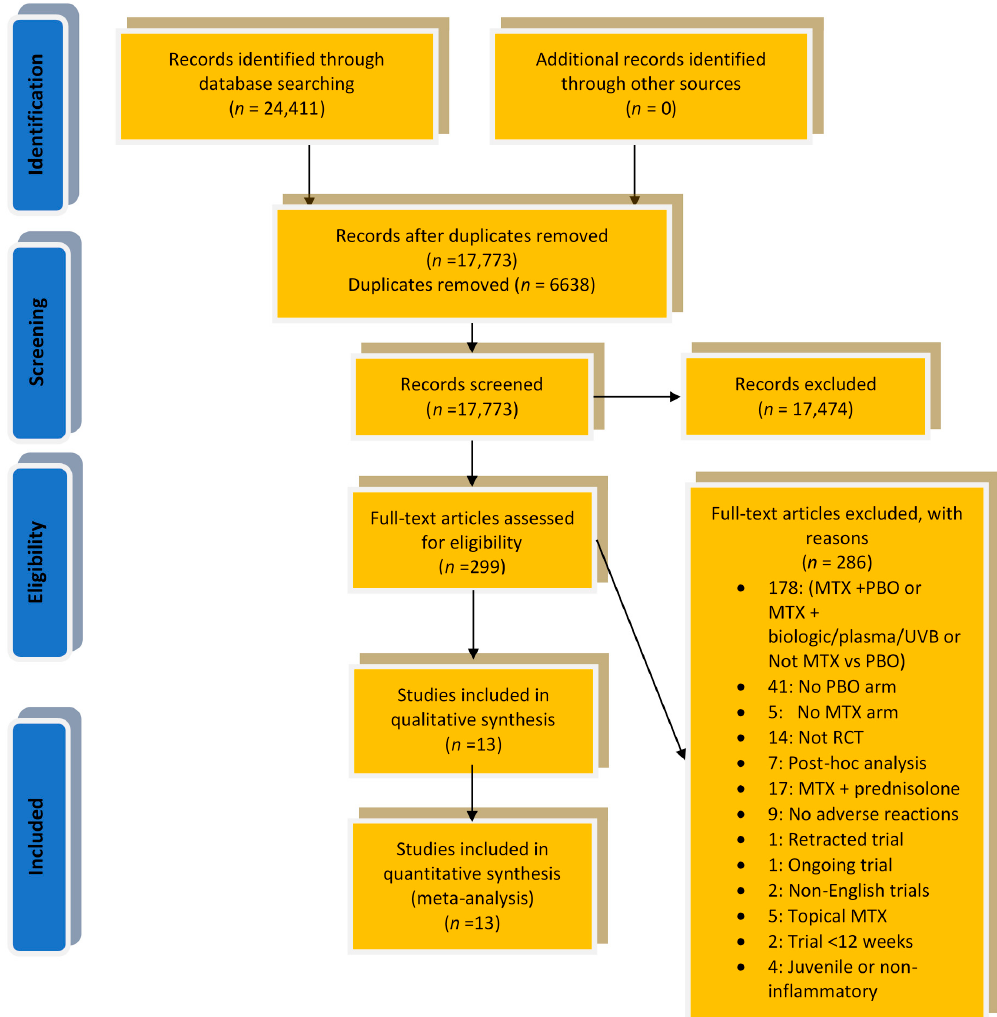
Figure 1. PRISMA flow diagram: Risk of infection of methotrexate therapy in inflammatory diseases (abbreviations: MTX—Methotrexate, PBO—Placebo, RCT—Randomized Controlled trial, UVB: Ultra violet B).